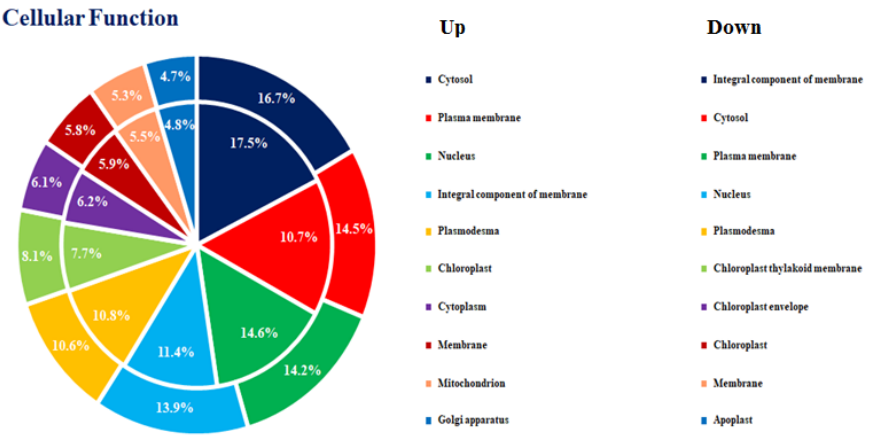
Figure 3. Summary of upregulated (outside) and downregulated (inner side) genes that involved in molecular function in ethylene-treated ‘Haegeum’ gold kiwifruit.